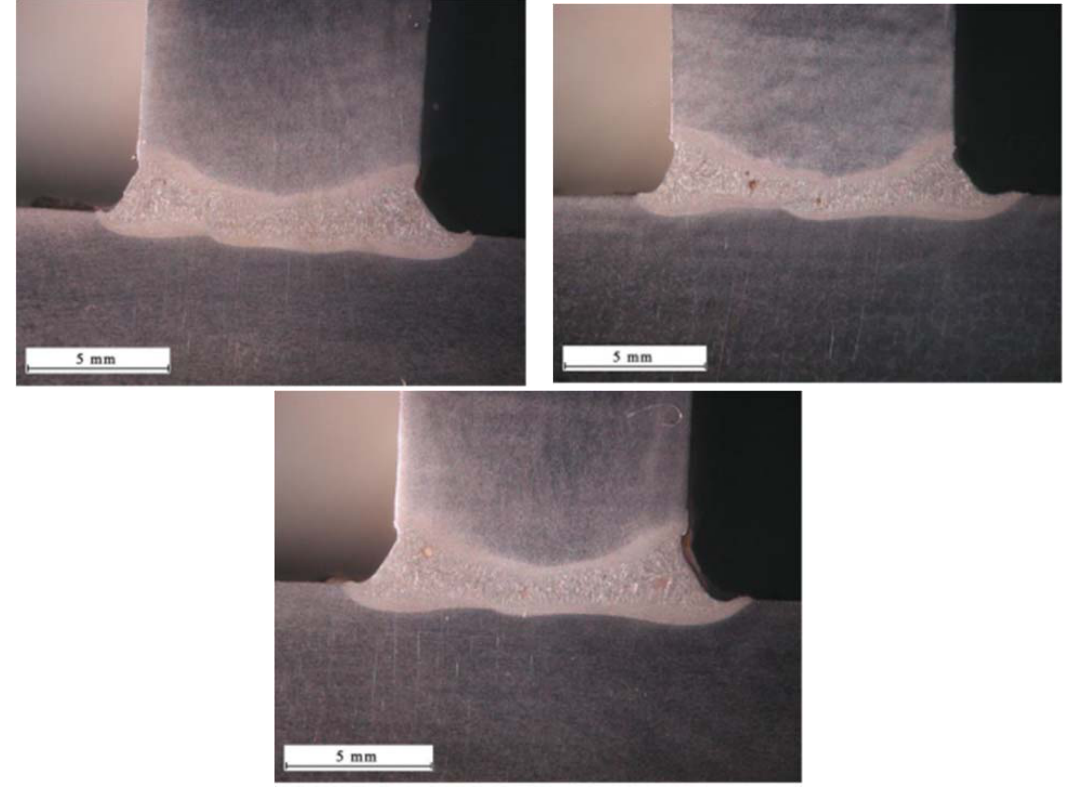
Figure 9. Macrostructure of the T ‐ joint in order 1–7, (Table 2).